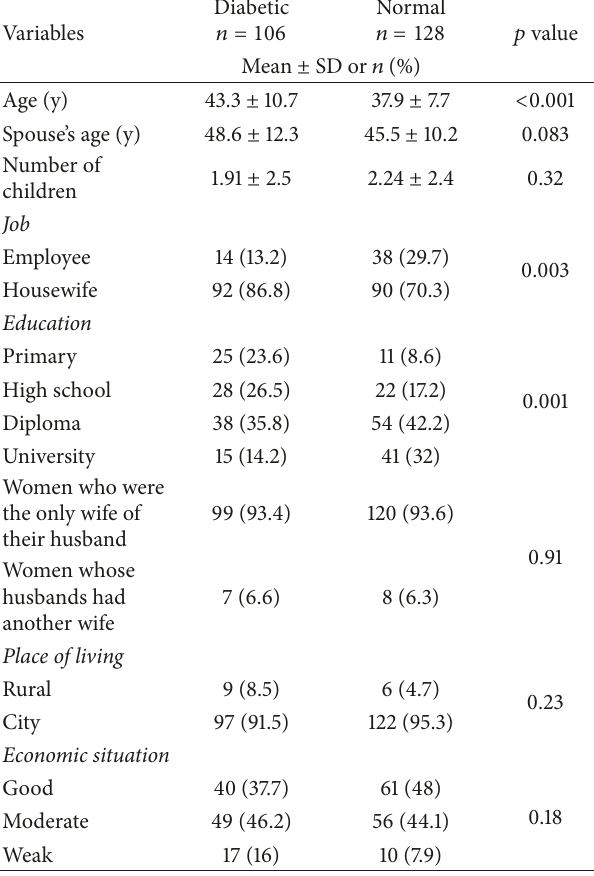
Table1:Thesociodemographiccharacteristicsofparticipantsintwo groups of diabetic and healthy women.